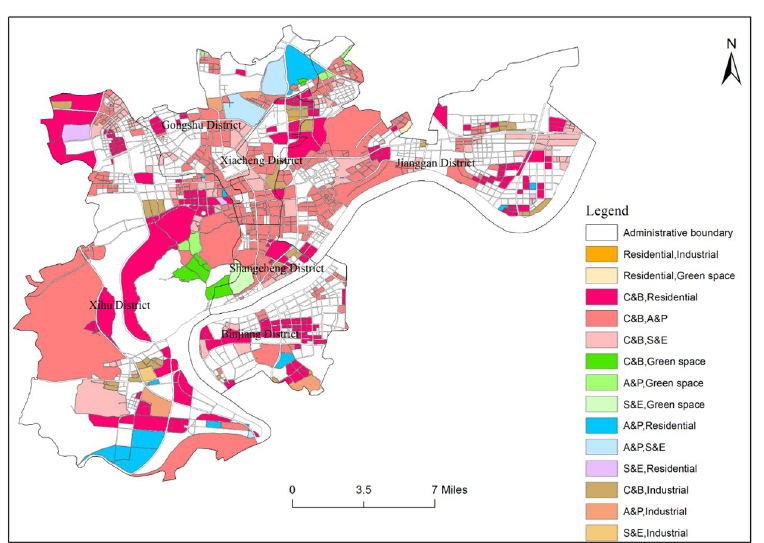
Fig 5. Distribution map of mixed functional areas in the central city area of Hangzhou.